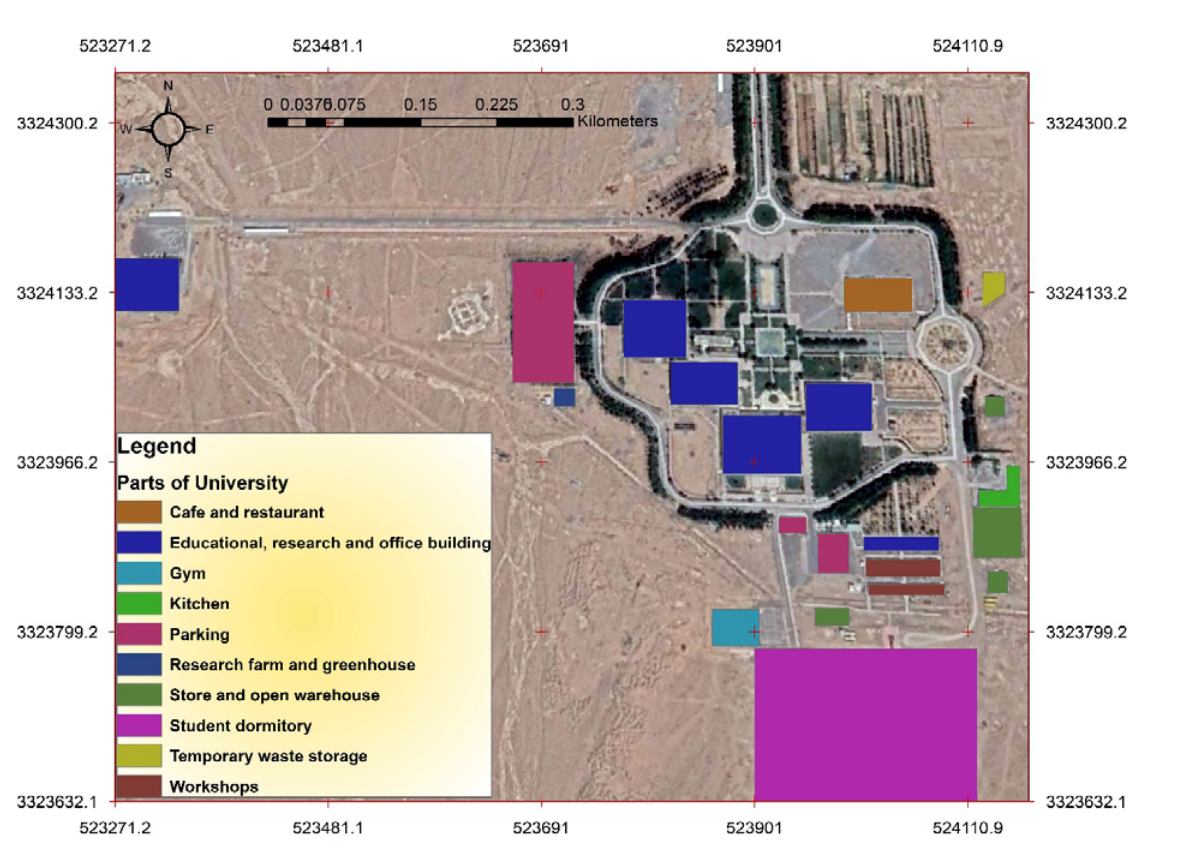
Figure 1. Kerman Graduate University of Technology map